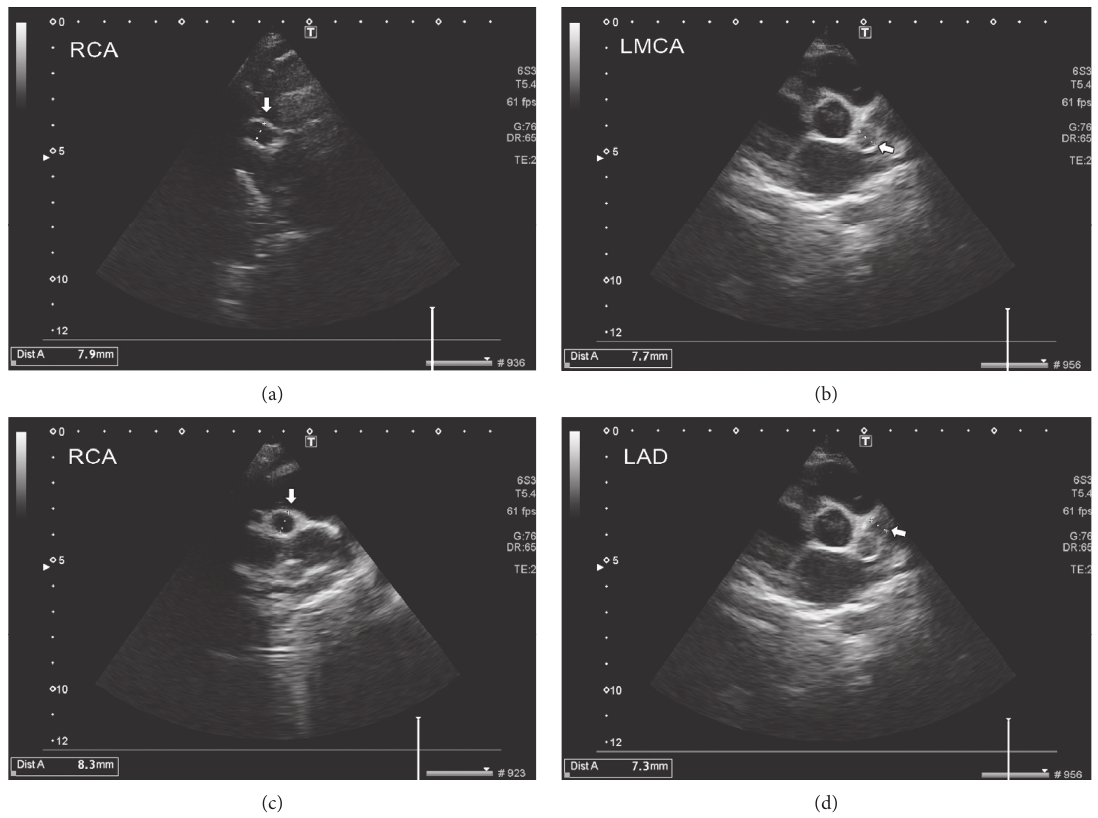
Figure 2: Echocardiography on the 20 th day of admission shows giant aneurysms in coronary arteries. (a) RCA, (b) LMCA, (c) RCA, and (d)